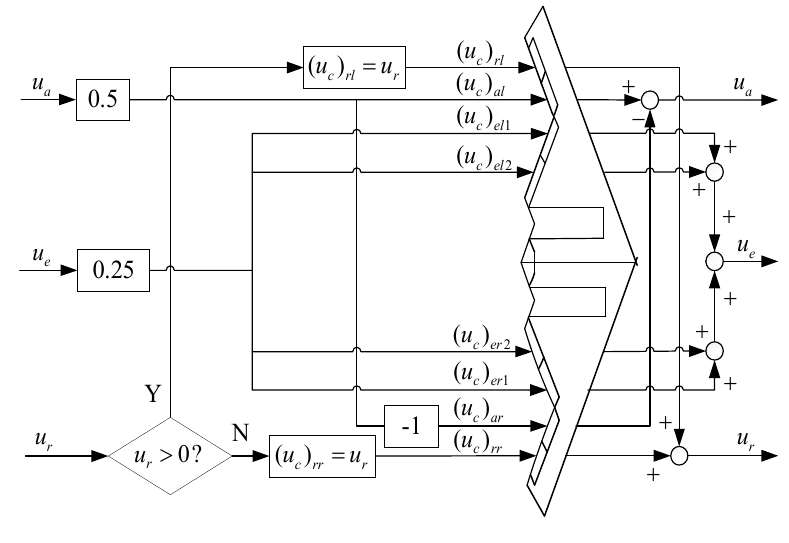
Figure 4. Control allocation without actuator fault.